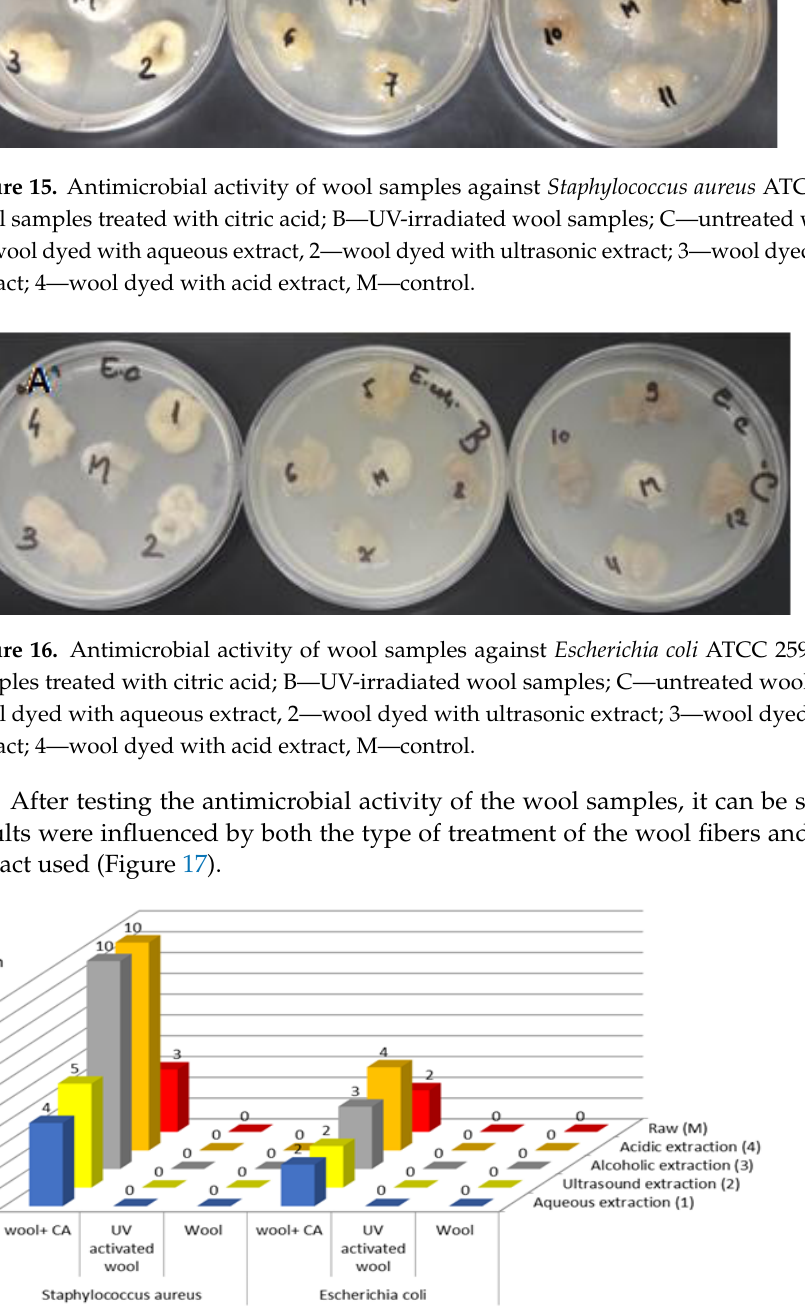
Figure 17. Zones of bacterial inhibition of treated wool